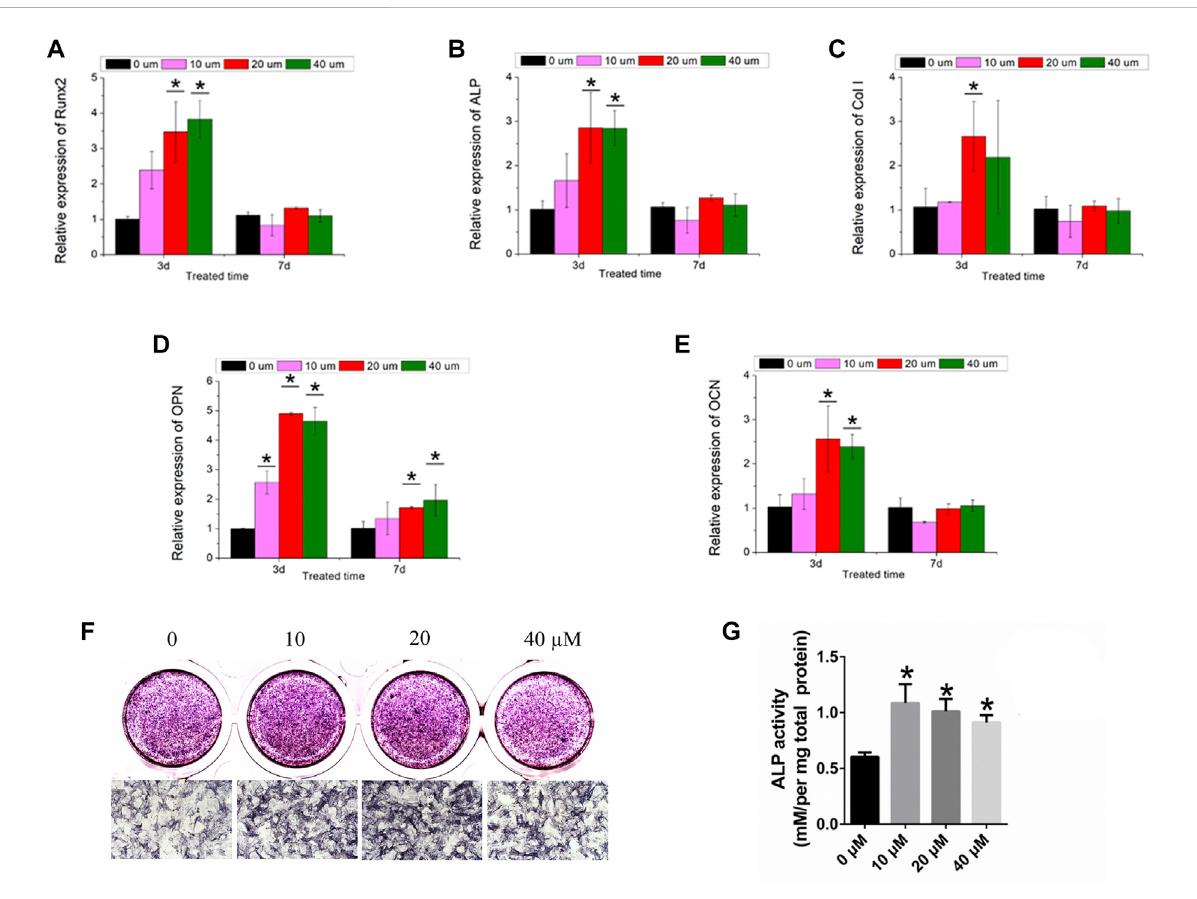
FIGURE 4 Osteogeniceffect of ginsenoside Rb1. (A – E) Relative expressionsof Runx2, ALP,Col-1, OPN,and OCN inBMSCs bydifferentconcentrations of ginsenoside Rb1 at days 3 and 7; (F – G) ALP staining and ALP quantitative activity assay of BMSCs administered with ginsenoside Rb1 (*, p <